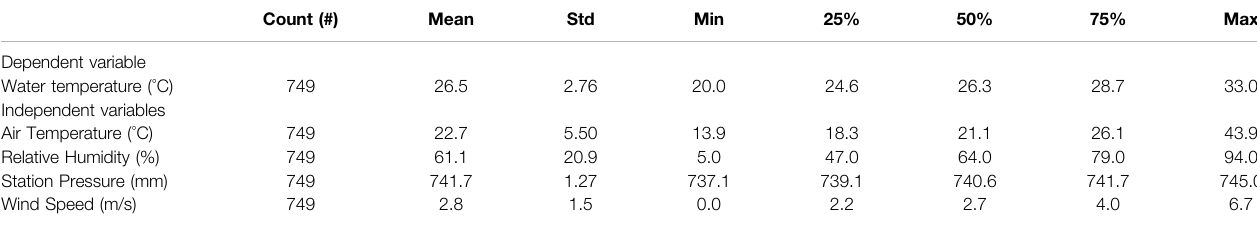
TABLE 1 | Statistical characteristics of the dependent and independent variables have been used in the ML model development. In the table, “ Std ” stands for standard deviation. Count